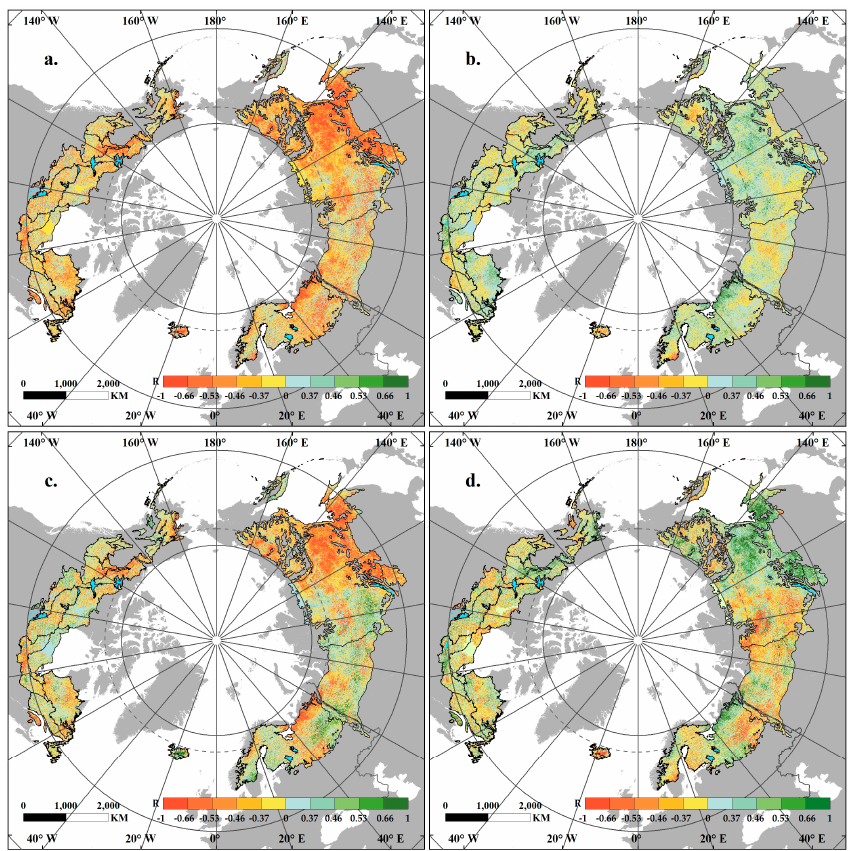
Figure 8. The spatial pattern of partial correlation coe ffi cients between the vegetation SOS date and ( a ) TMAX during the TMAX preseason; ( b ) TMIN during the TMAX preseason; ( c ) TMAX during the TMIN preseason; ( d ) TMIN during the TMIN preseason. The 1%, 5%, 10%, and 20% significance levels of the partial correlations correspond to ± 0.66, ± 0.53, ± 0.46, and ± 0.37,